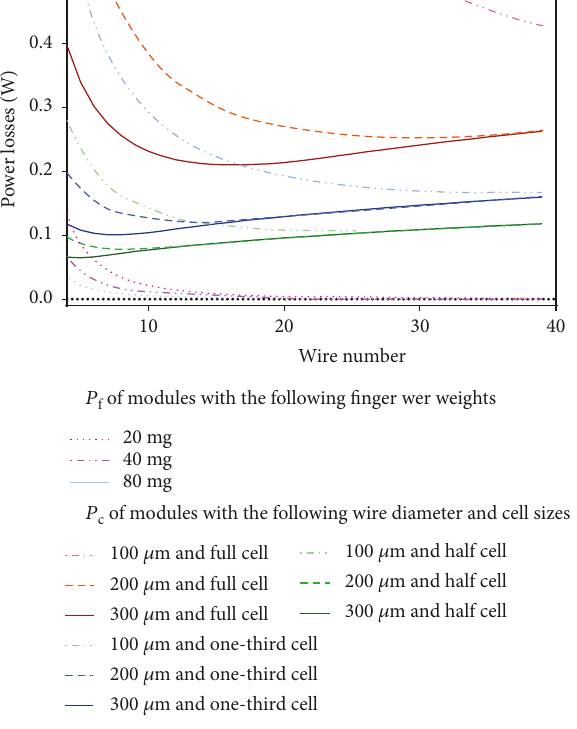
Figure 12: Relationship between the number of the wires and the following power losses of a module whose cell area is equal to a full cell: resistance power losses of fi ngers with wet weights of 80mg, 40 mg, and 20mg per full cell; power losses of conductive belts with wire diameters of 100 μ m, 200 μ m, and 300 μ m, and with cell sizes of full, half, and one-third.